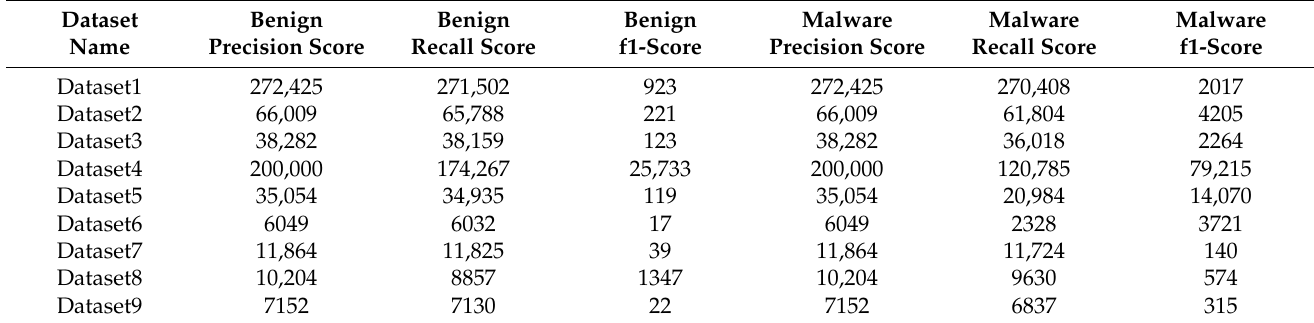
Table 13. Confusion matrix for testing the DT algorithm with minimum features.